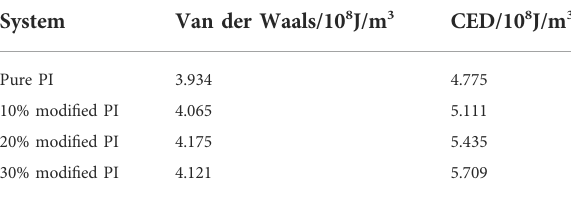
TABLE2PolyimidevanderWaalsforceandcohesiveenergydensityof different systems.